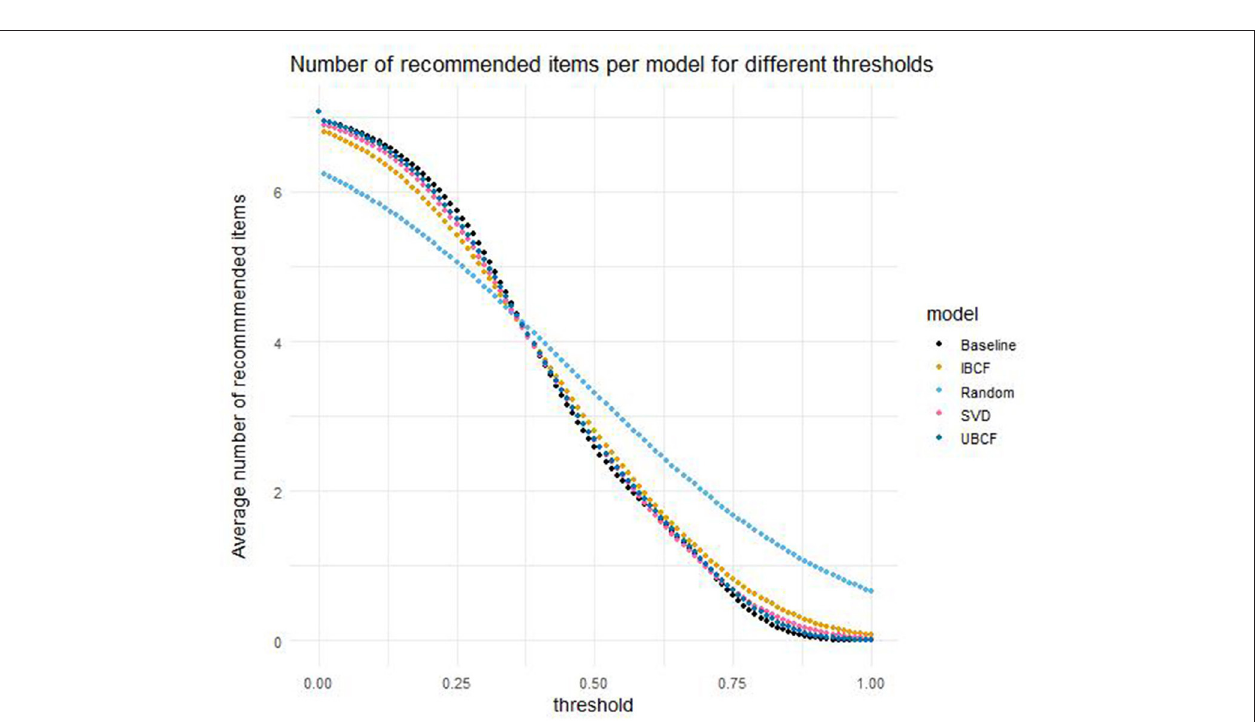
FIGURE 6 | Number of recommended items per model and threshold, averaged over students and cross-validation